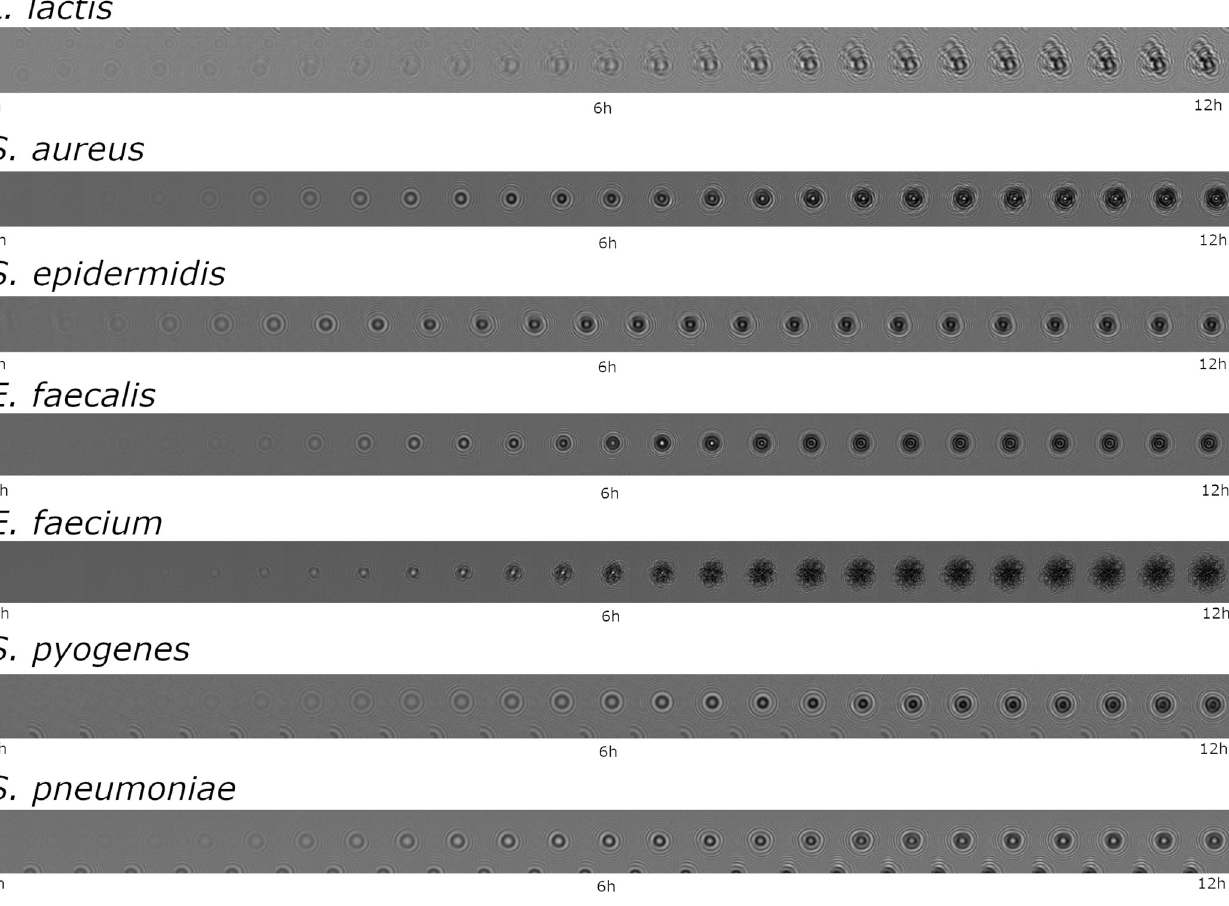
PLOS Digital Health | https://doi.org/10.1371/journal.pdig.0000122 October 5,